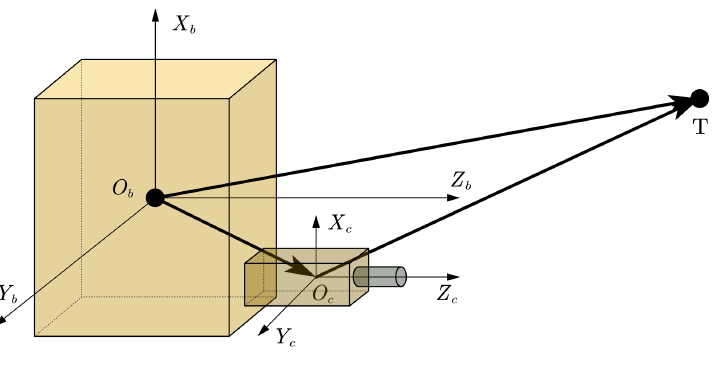
Figure 3. The extrinsic camera